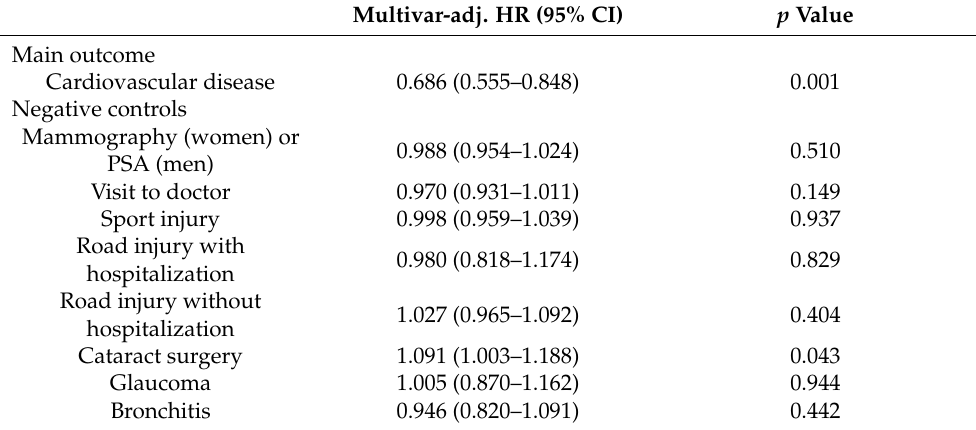
Table 5. Negative controls: HR (95% confidence intervals) for every 2 additional points in the baseline MDS in the “Seguimiento Universidad de Navarra” (SUN) cohort, 1999–2019. Multivar-adj. HR (95% CI) p Value Main outcome Cardiovascular disease 0.686 (0.555–0.848) 0.001 Negative controls Mammography (women)